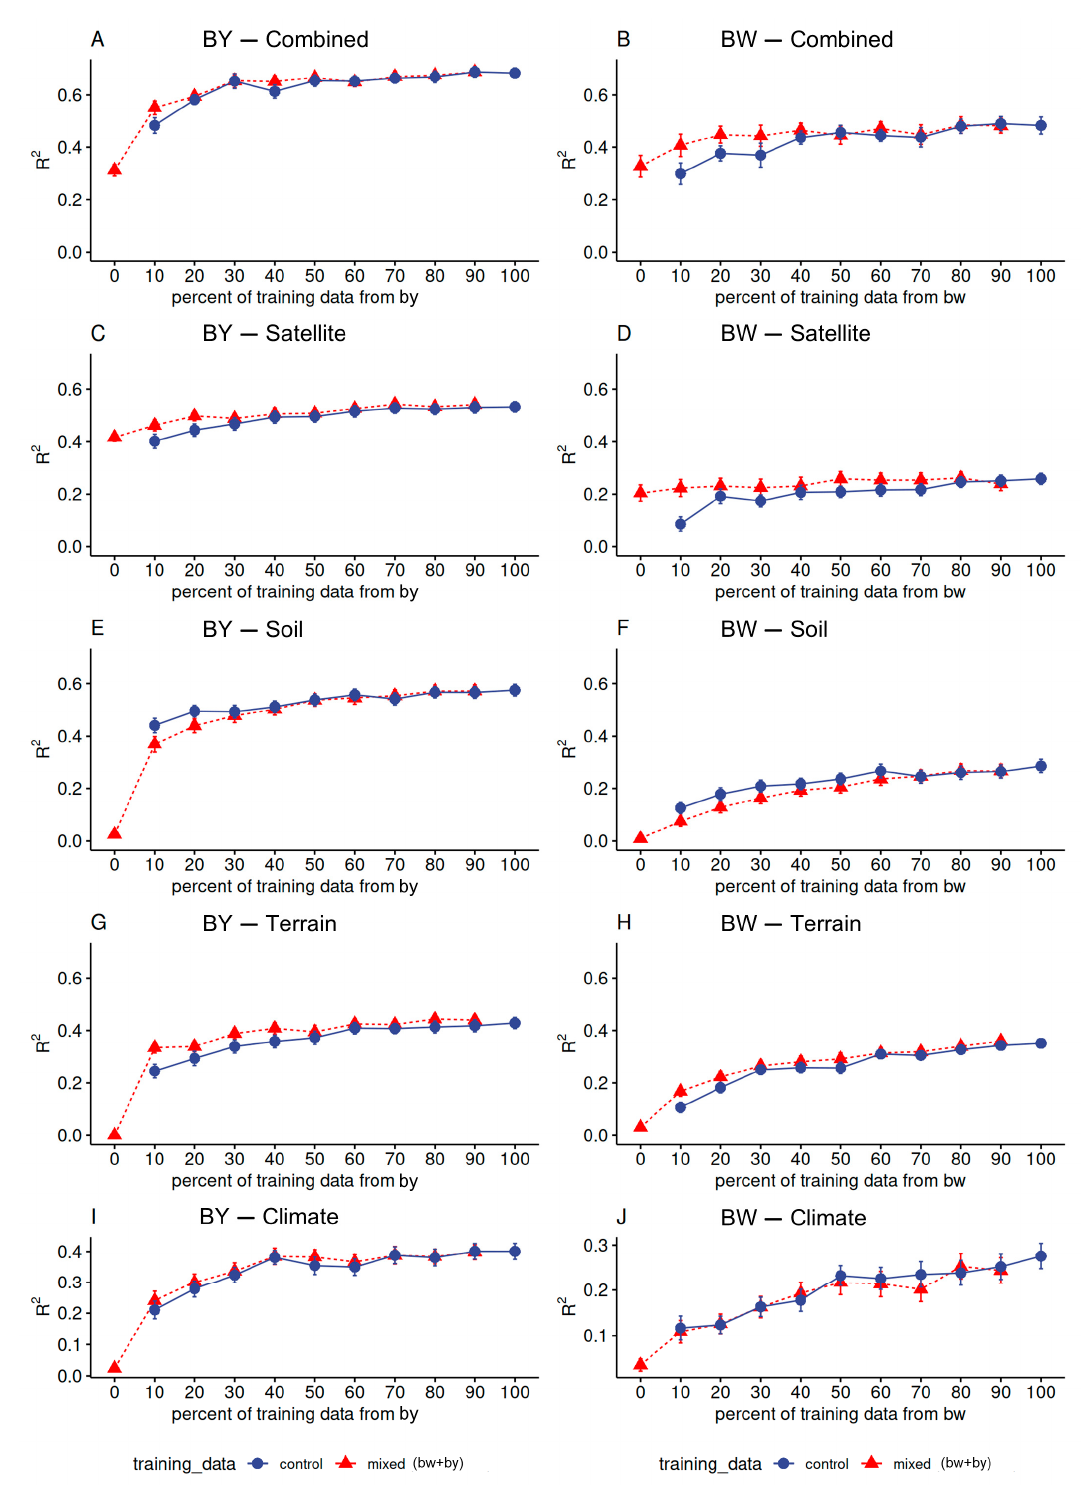
Figure 7. Results ( R 2 ) of mixed-data (red) and control models (blue) for each covariate group. Mean values and SE of the 6 times 10-fold cross-validation are shown. The x-axis corresponds to the percentage of training samples from the state in which the models were tested. Control models were trained with the same data but without additional samples from the other state.